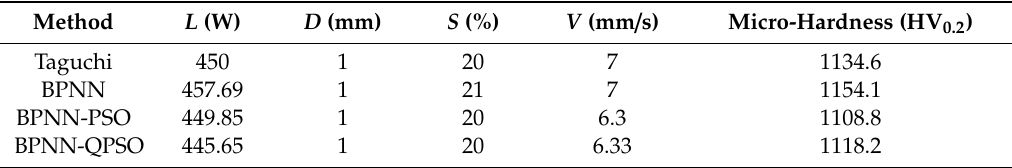
Table 7. Optimization results of process parameters.